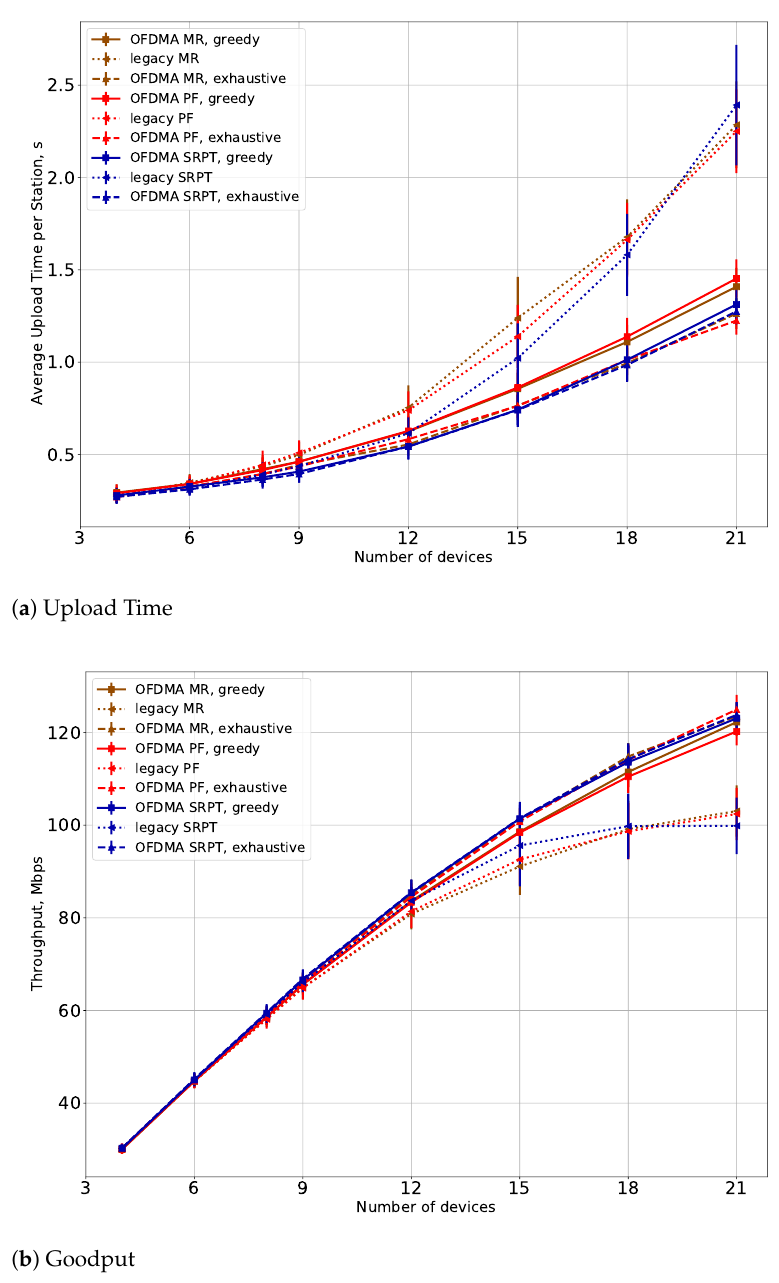
Figure 4. ( a ) Upload time and ( b ) goodput for the proposed greedy schedulers in comparison with optimal solution and legacy schedulers for small numbers of